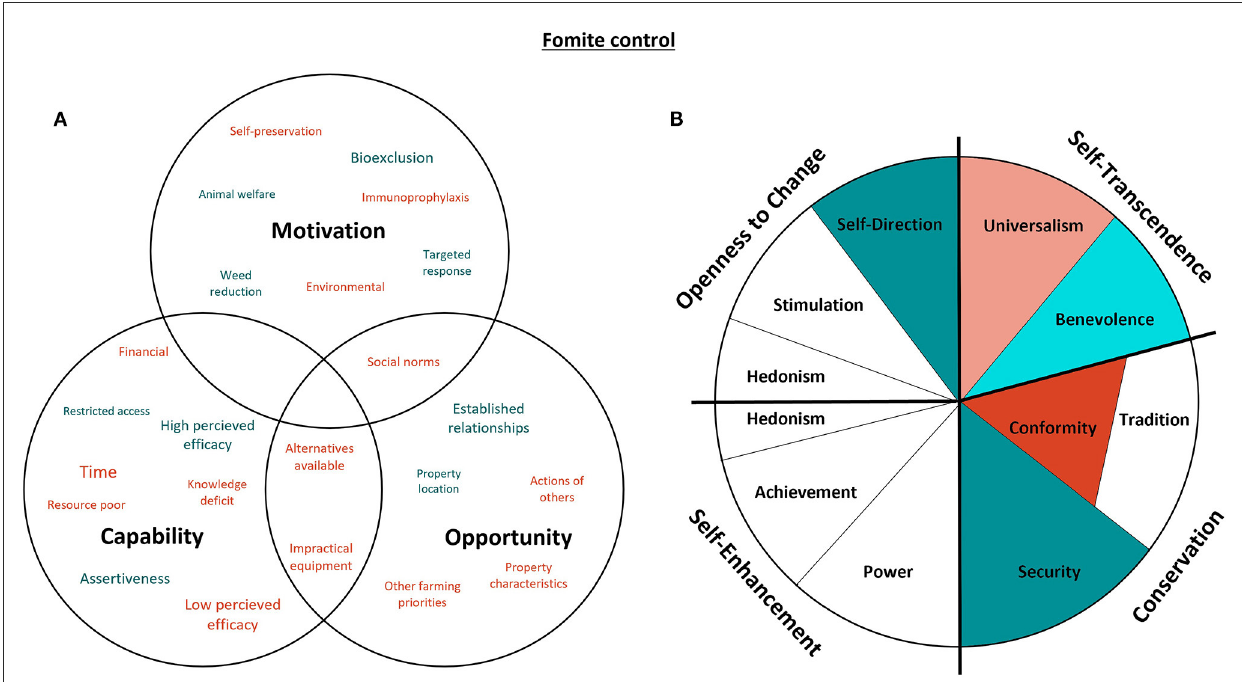
FIGURE7 Capability, opportunity, motivations and values associated with the control of fomites. Green represents attributes that promote the control of fomites, while red indicates confounding attributes. The size of the text in (A) indicates the commonality of themes amongst the participants, as does darker shading in (B) [adapted from Schwartz (29). CC BY-SA 4.0].